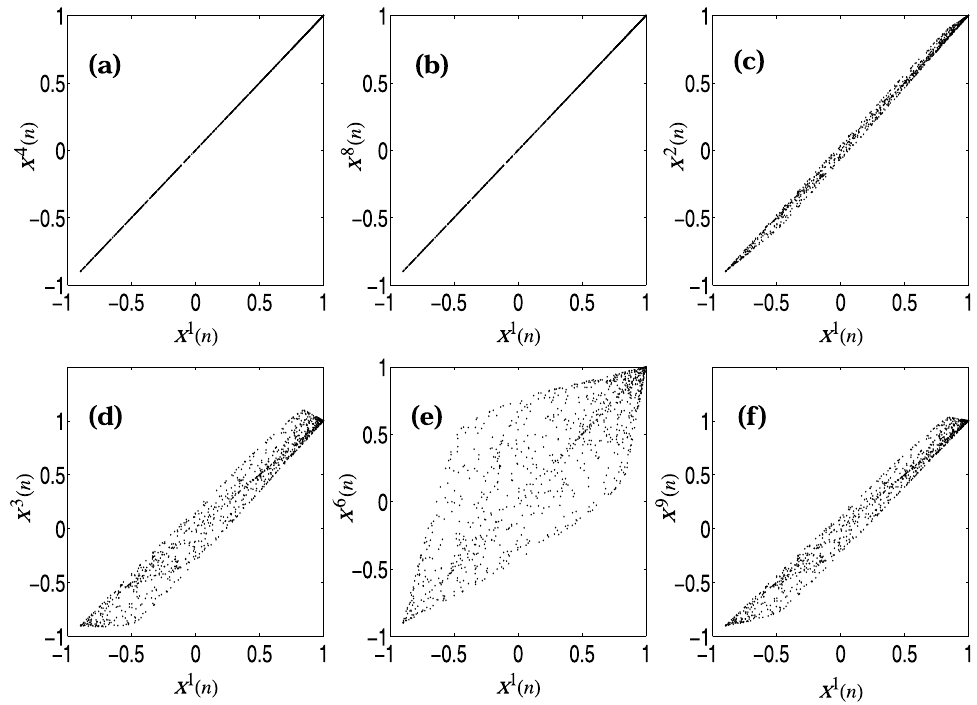
Figure 1. Targeted synchronization of coupled logistic maps where the synchronized value coincides with the average value x ( n ): ( a and b ) the synchronization of the first map with 4th and 8th maps, ( c – f ) the desynchronization of other maps (2, 3, 6 & 9) with the first